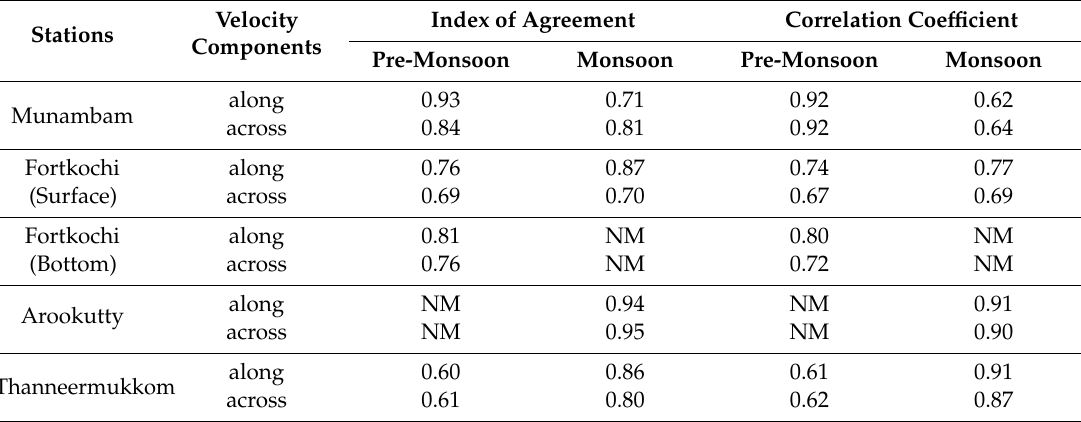
Figure 7. Normalized Taylor diagram for the statistical significance of across-channel velocity of the model during the ( a ) pre-monsoon (2010) and ( b ) monsoon (2010). Table 3. Index values for the model and correlations of the time series currents (U and V components) at four locations in CE during pre-monsoon (2010) and monsoon